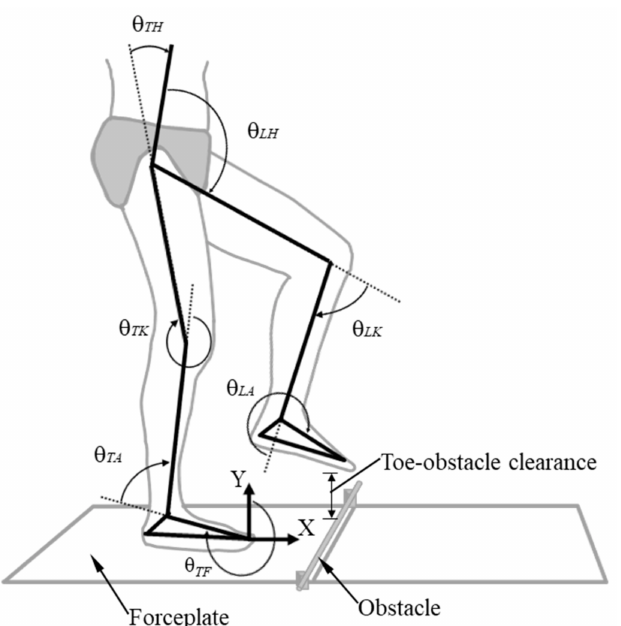
Figure 1. The sagittal seven-link model of the body during obstacle crossing with seven degrees of freedom, corresponding to the angular displacements: hip ( θ LH ), knee ( θ LK ), and ankle ( θ LA ) of the leading swing limb, and foot ( θ TF ), ankle ( θ TA ), knee ( θ TK ), and hip ( θ TH ) of the trailing stance limb. Toe-obstacle clearance is also indicated, defined as the vertical distance of the toe above the obstacle. The X-axis indicates the direction of